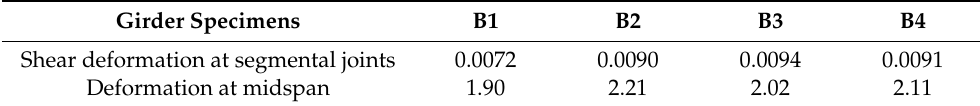
Table 1. Maximum deformation test values of girder specimens (unit: mm).